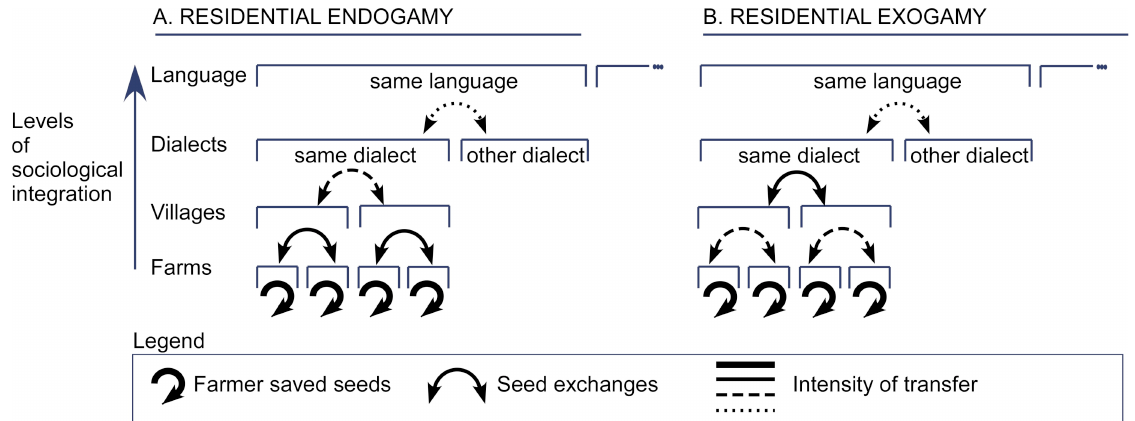
Figure 2. Expected effects of residential endogamy on the orientation of seed exchanges and spatial distribution of crop genetic diversity. Pattern (A) : Baka communities (Cameroon). Residential endogamy (husband and wife are from the same village): seeds are obtained from the in-law family which is from the same village; this favors genetic differentiation among villages; Pattern (B) : Nzimo communities (Cameroon). Residential exogamy: (husband and wife are from different villages): seed exchanges are oriented outwards, which results in lower genetic differentiation among villages. Patterns A and B produce different structures of crop metapopulations, affecting crop genetic organization at different levels of sociological